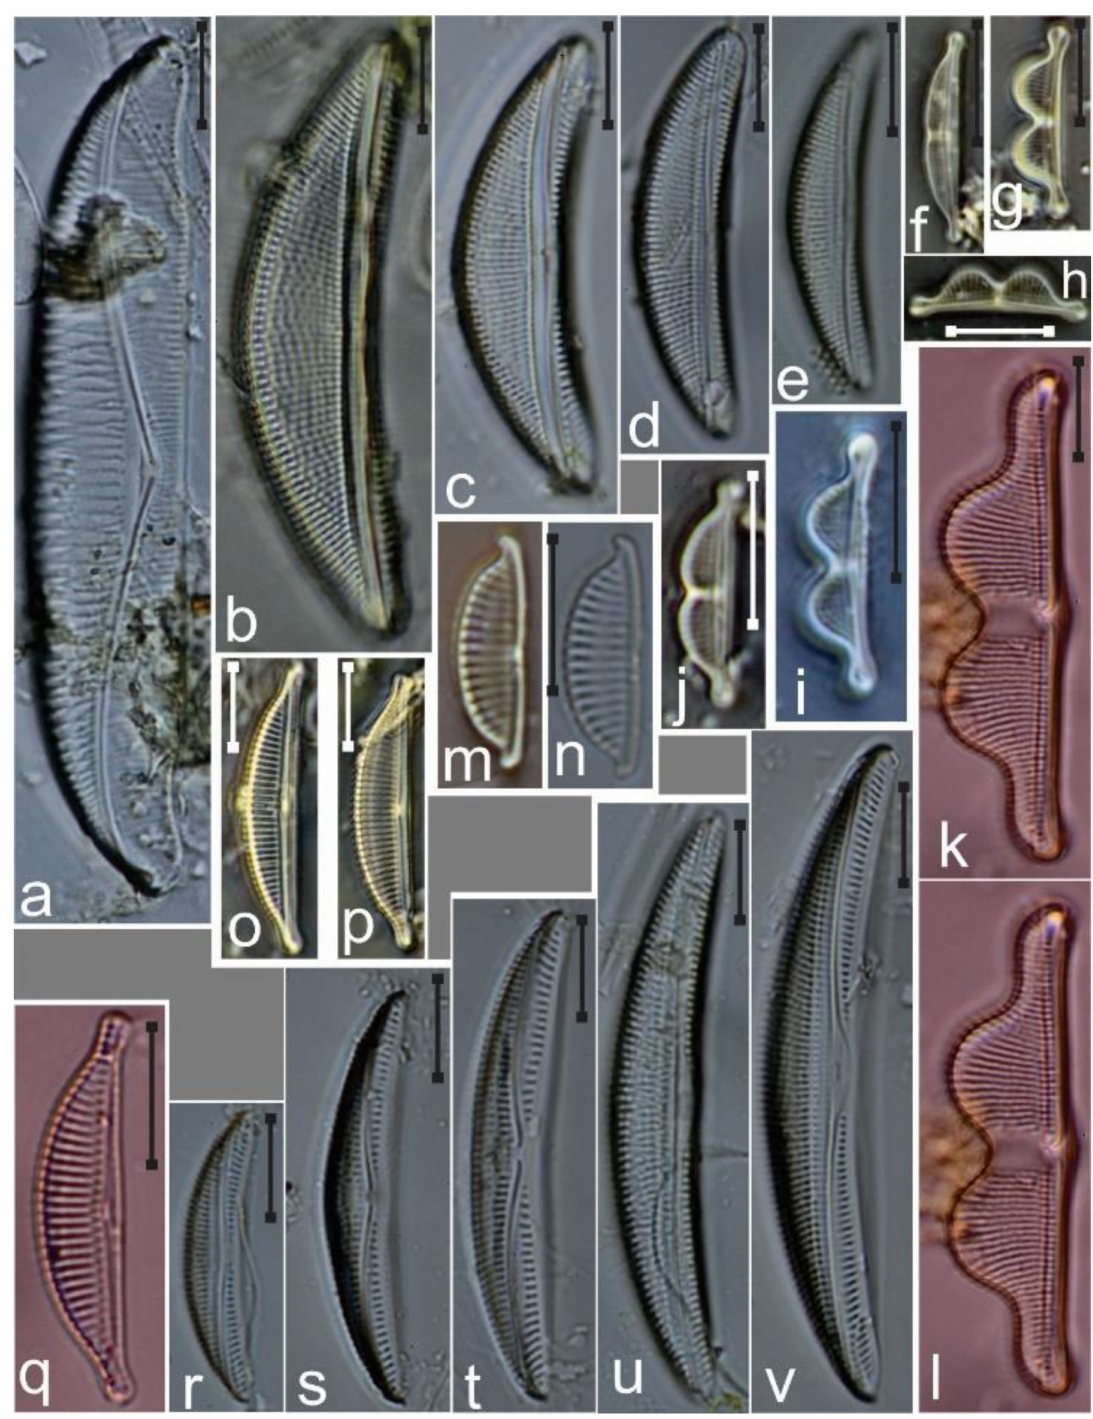
Figure 34. ( a ) Amphora spectabilis ; ( b – e ) A. immarginata ; ( f – h , j ) A. bigibba ; ( i ) Halamphora capitata ; ( k , l ) Amphora bigibba var. interrupta ; ( m , n ) Halamphora wisei ; ( o , p ) H. co ff eiformis ; ( q ) H. acutiuscula ; ( r ) Amphora proteus var. contigua ; ( s , t ) A. marina ; ( u , v ) A. proteus . Scale bar = 10 µ